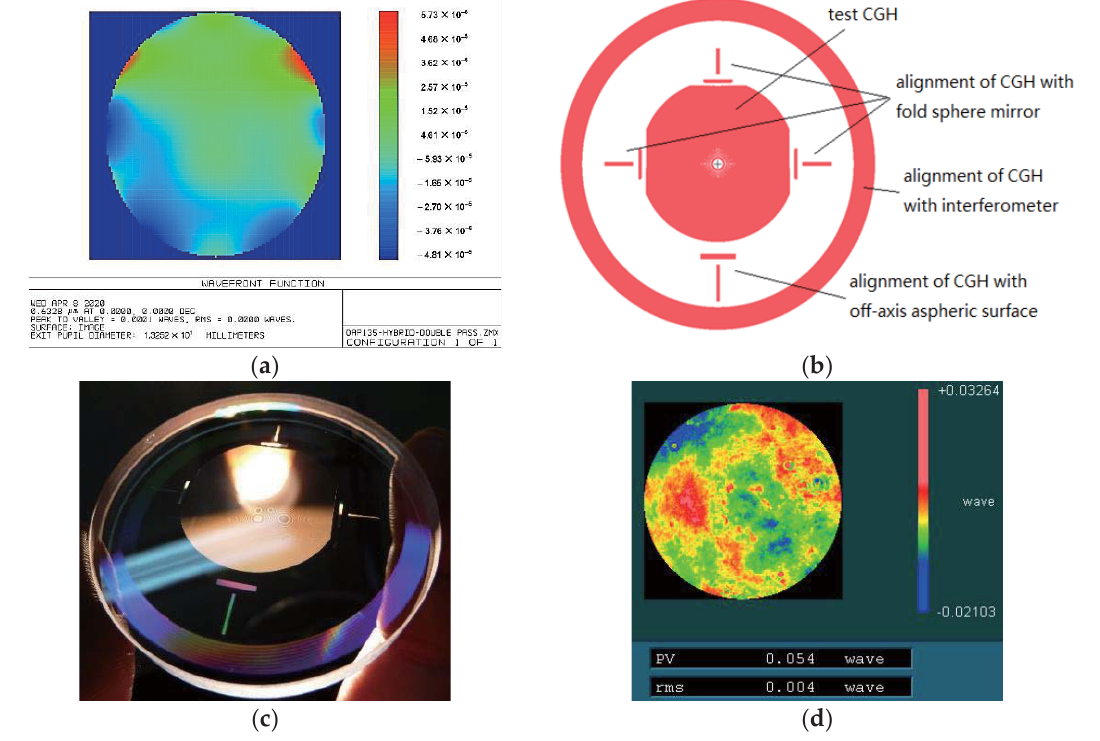
Figure 10. ( a ) Simulated residual wavefront of the hybrid compensation method (test CGH) in Zemax (PV = 0.0001 λ ); ( b ) simulation pattern of the customized CGH for this hybrid compensation system; ( c ) CGH photograph; ( d ) error of the fold sphere mirror (PV = 0.054 λ ).